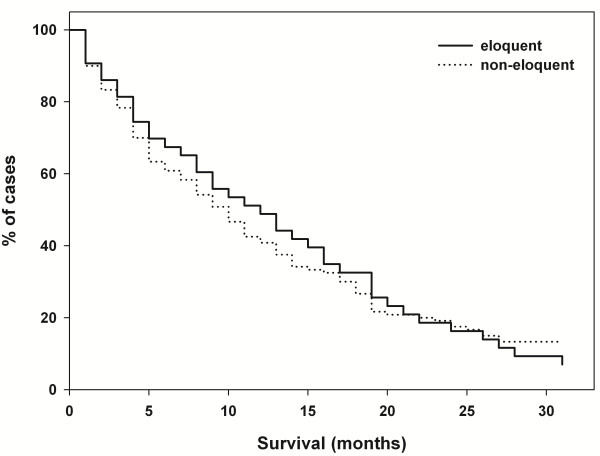
Survival. Kaplan-Meier survival analysis of motor eloquently and non-eloquently located brain metastases.